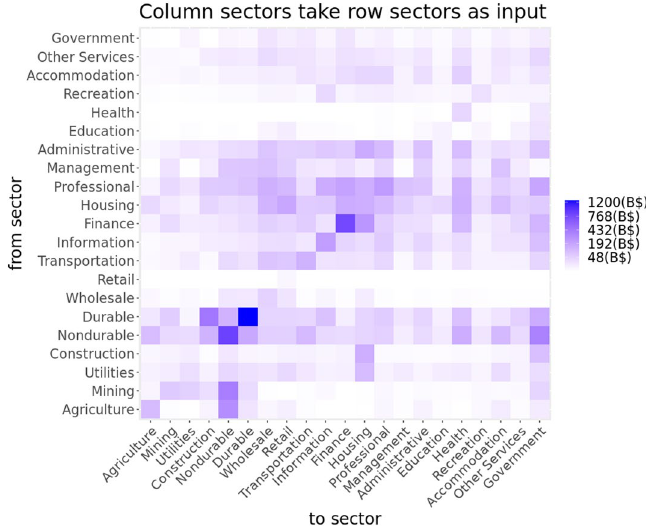
Figure 3. This figure shows interdependencies between sectors as given by the US Bureau of Economic Analysis. The left sector flows are input to right sectors.